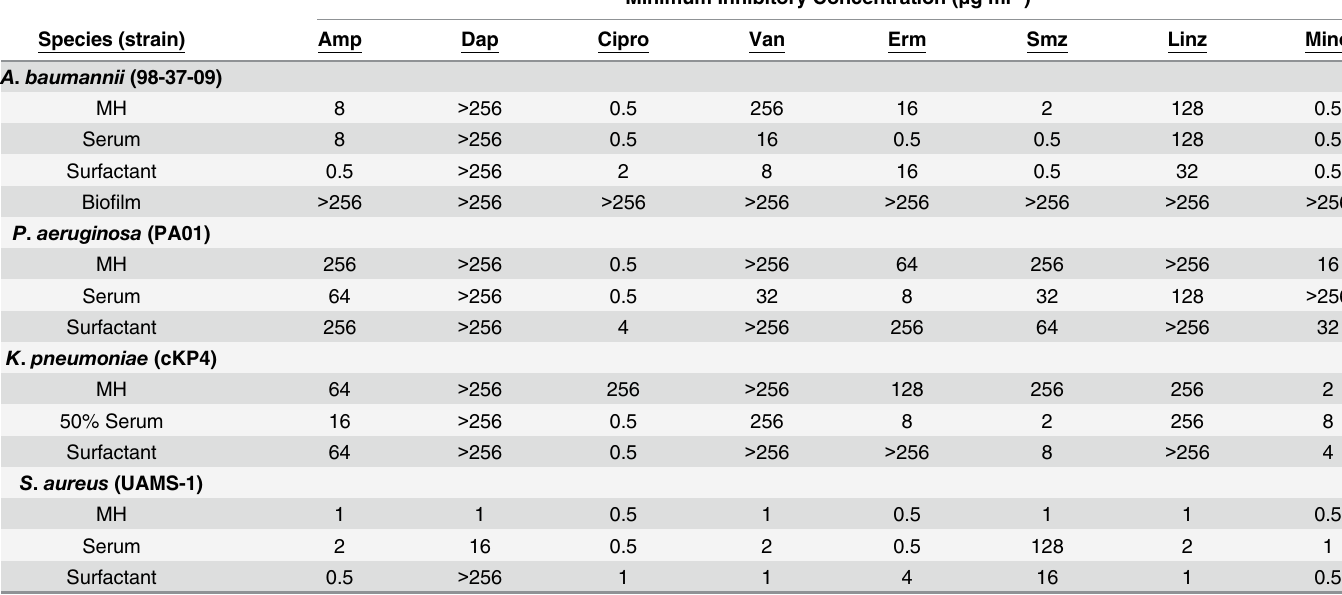
Table 2. Antimicrobial susceptibility